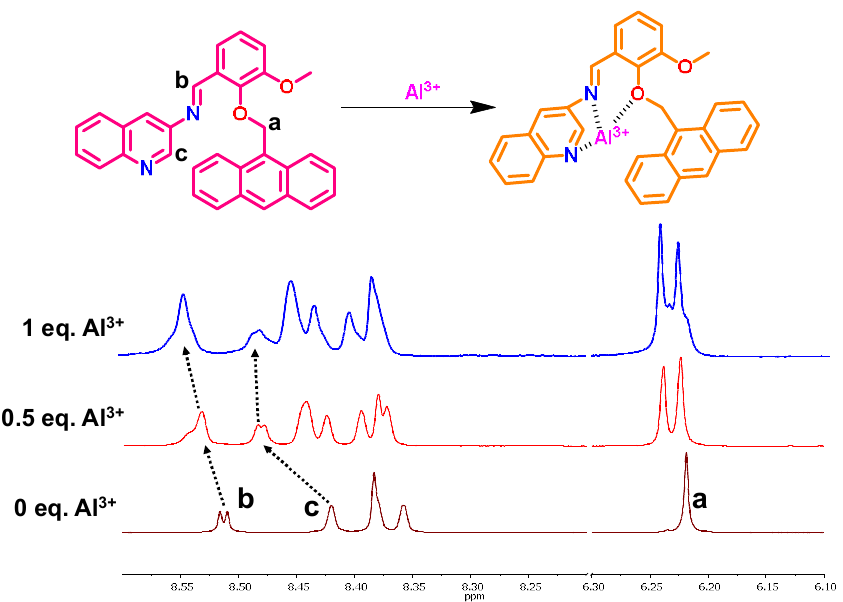
Figure 9. Selected part of 1 H NMR spectra displaying the titration of L1 with the Al 3+ ion (0–1 equiv.) in CDCl 3 . See Figure S20 for full-range spectrum.